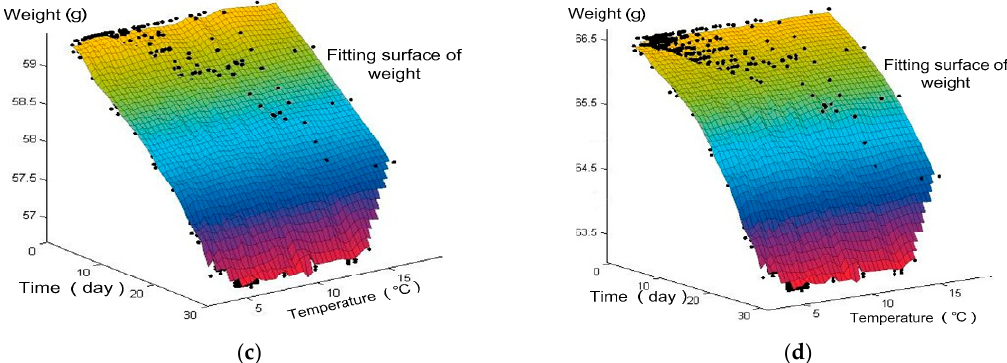
Figure 8. Weight changes of n-3 PUFAs enriched and conventional eggs under different conditions. ( a ) Weight changes of n-3 PUFAs enriched eggs under room temperature; ( b ) Weight changes of conventional eggs under room temperature; ( c ) Weight changes of n-3 PUFAs enriched eggs in refrigeration; ( d ) Weight changes of conventional eggs in refrigeration.